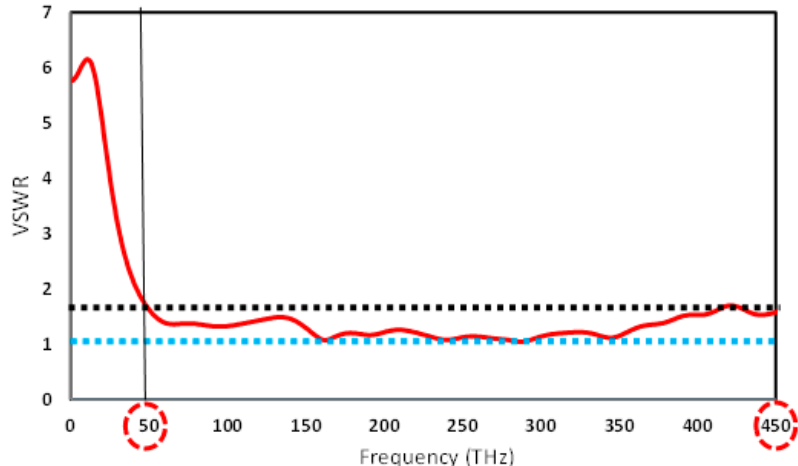
Figure 6. VSWR values for the proposed antenna.